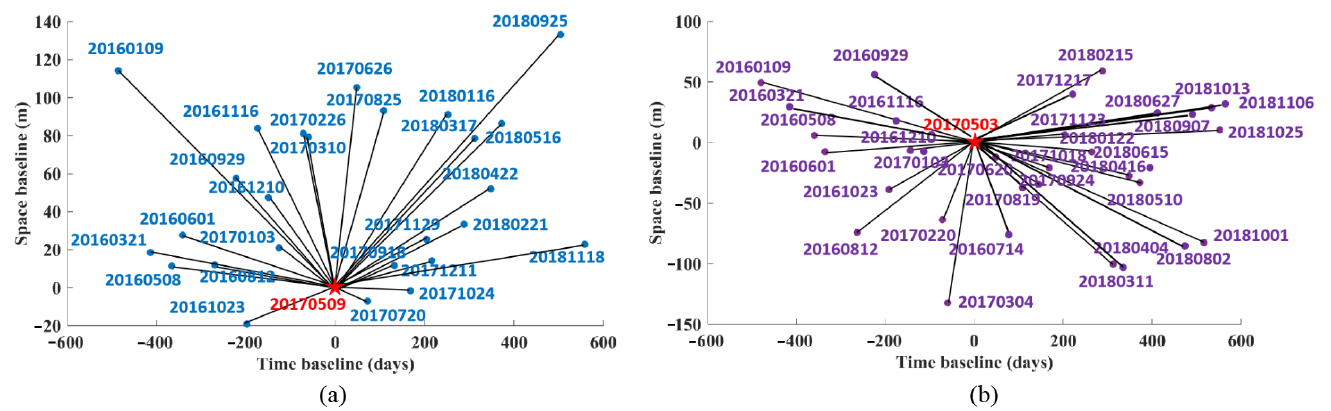
Figure 3. Coverage of the ascending track and descending track SAR data in the study area.